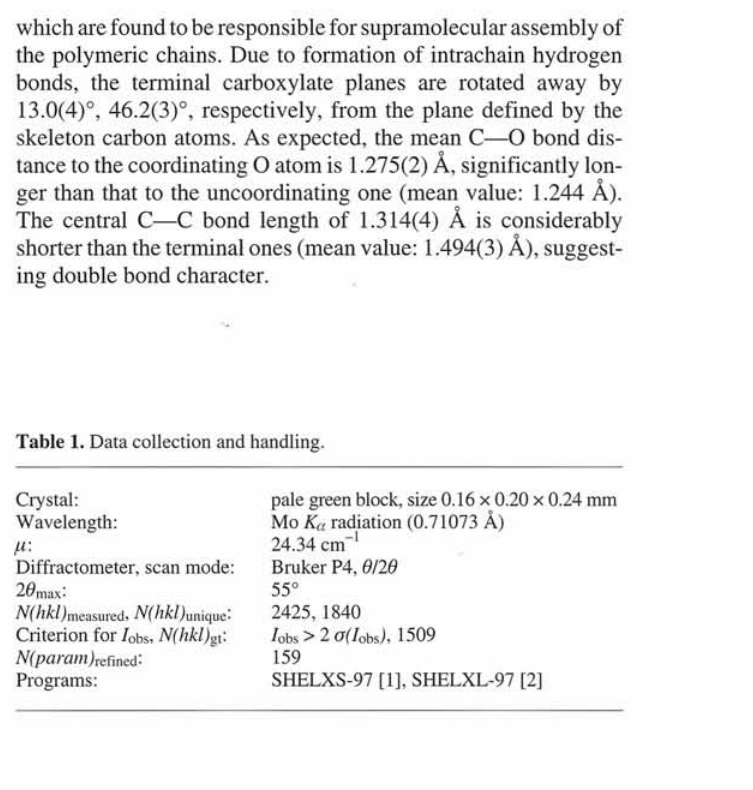
o 7 Table 2. Atomic coordinates and displacement parameters (in